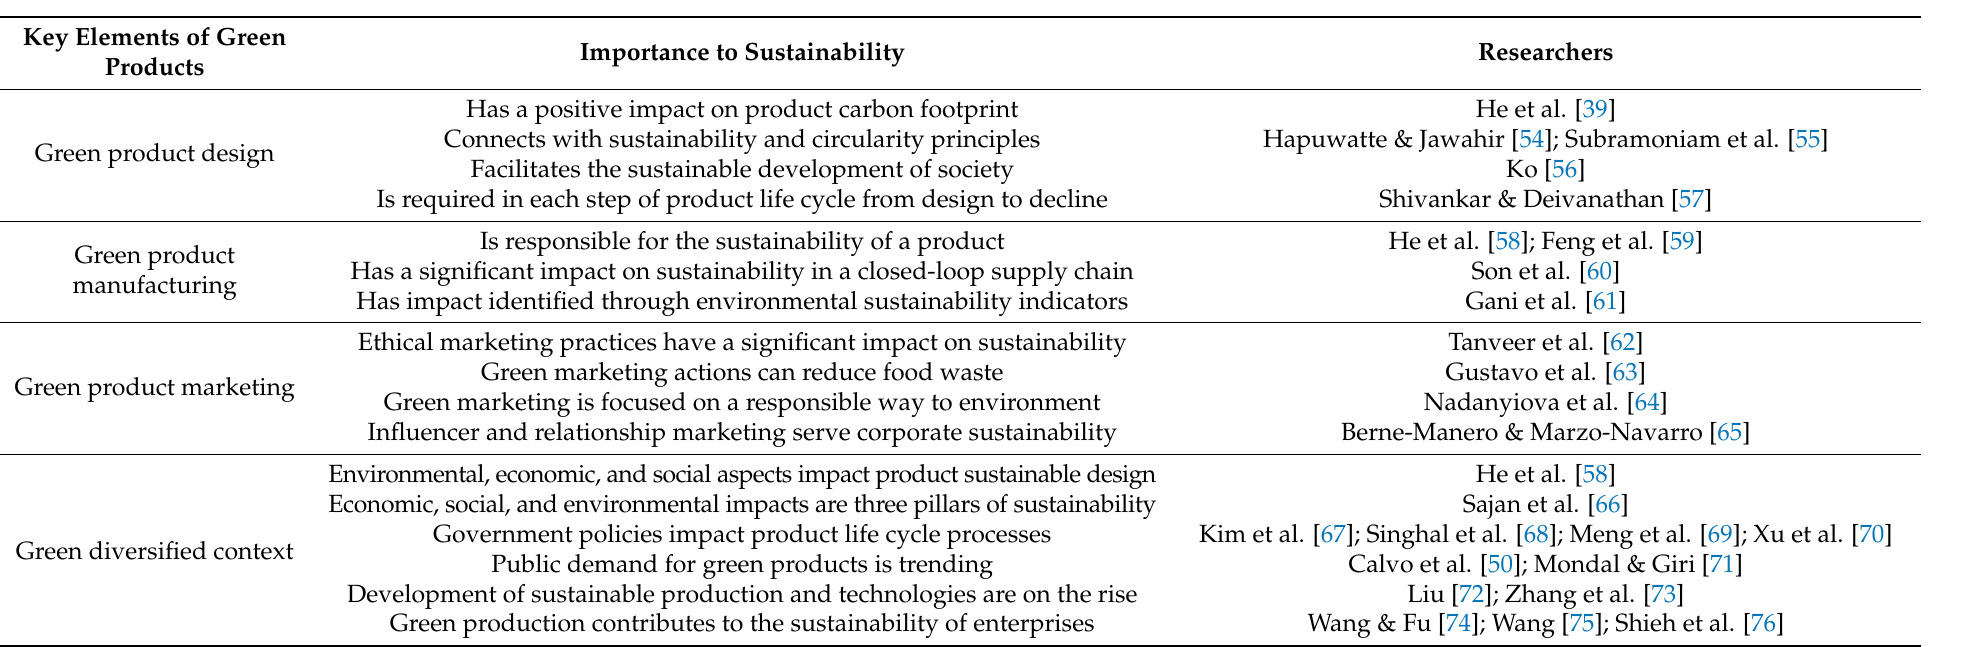
Table 1. Key elements of green products and their value to